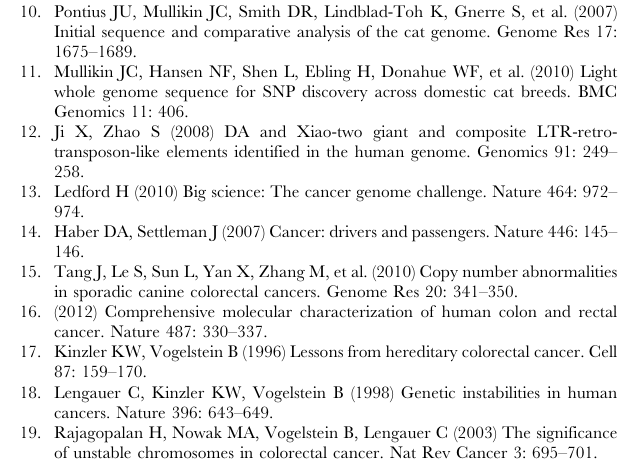
File S4 Detailed information for each mutated codon of APC and the other 10 canine genes in the adenocarcinomas listed in Table S2, including large deletions, small indels, nonsense mutations, missense mutations, and base substitutions. (TGZ) Table S1 Canine colorectal adenoma and adenocarcinoma samples used for bi-directional exon-resequencing analysis. (XLS) Table S2 Canine colorectal tumor and normal tissue samples used for qPCR analysis. (XLS)